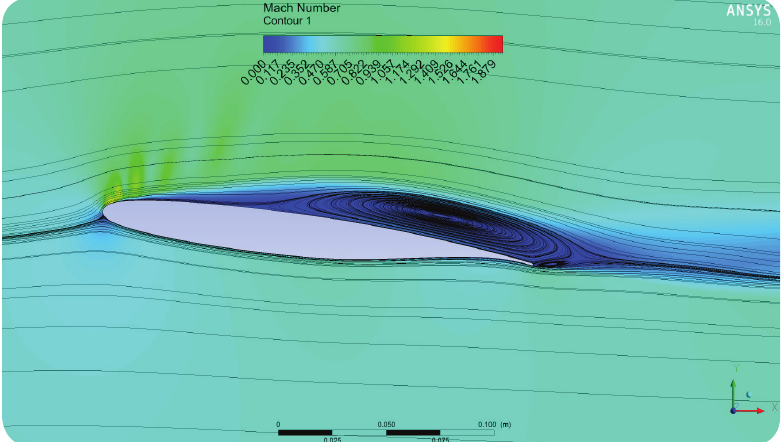
Figure 34. Mach contour, pitch motion α (t) = 3 + 3 sin( w t), frequency = 3 Hz, Mach = 0.6, Alpha = 5°.